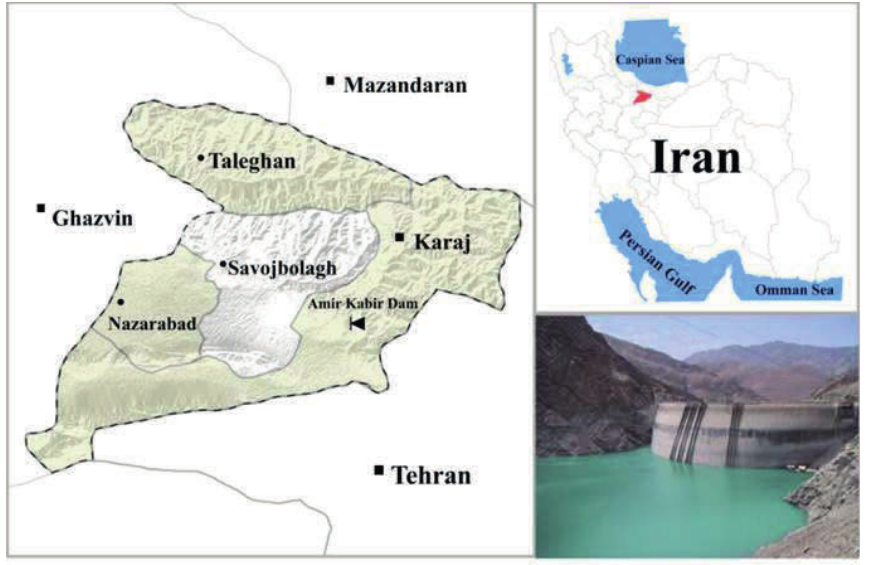
Fig. 1. Location of Amirkabir Dam in Iran